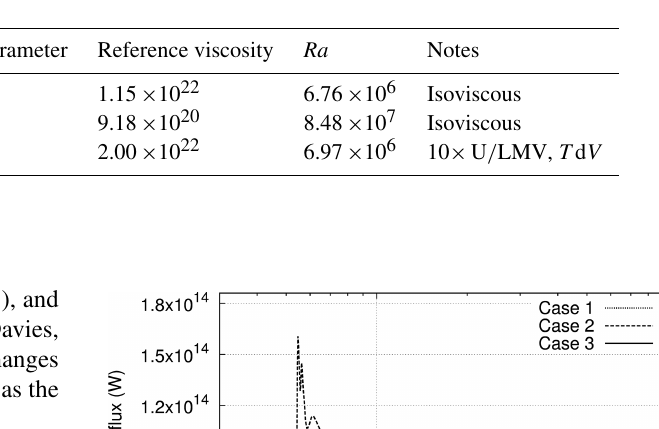
Table 2. Model cases. Cl660 is the Clapeyron slope at 660; Ra is Rayleigh number (Eq. 1). U / LMV is the upper–lower mantle viscosity contrast; T d V indicates temperature-dependent viscosity.